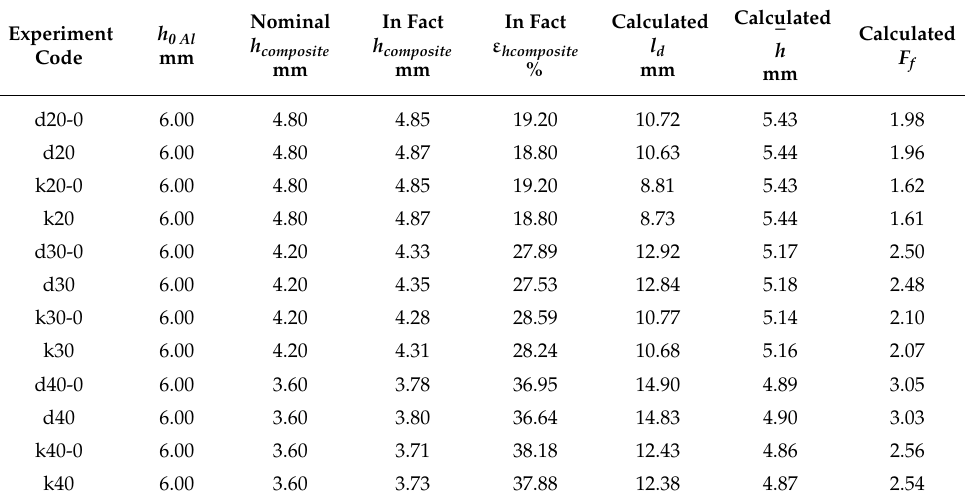
Table 1. Nominal and experimental thicknesses of roll-bonded composites: h 0 Al —the sum of the thicknesses of both layers of the aluminum matrix; h composite —thickness of the roll-bonded composite ε hcomposite —rolling reduction of whole composite (1); l d —the length of the deformation zone (2); h —the average thickness of the composite in the deformation zone (3); F f —the form factor of the deformation zone